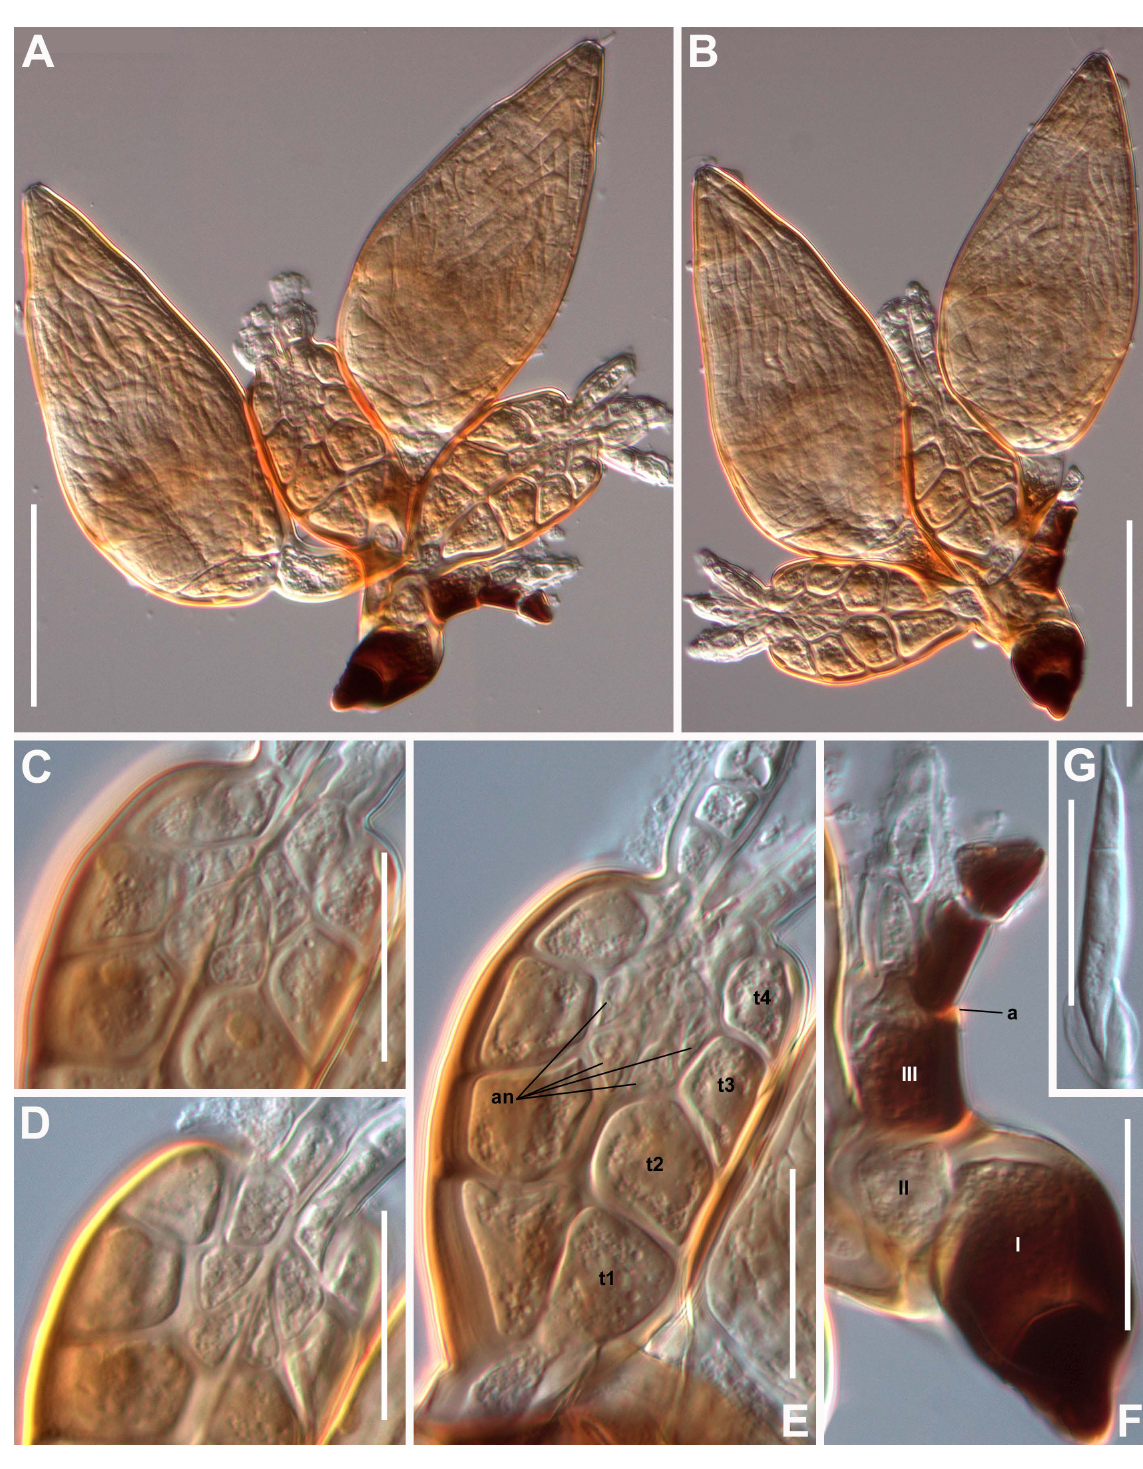
Fig. 91. Monoicomyces validus Santam. sp. nov. A – B . Mature thalli. C – E . Antheridium at three focusing levels. C – D . Respectively in near and far focus. E . Middle focus in detail with the four tiers of cells (t1–4), and four phialides (an). F . Lower receptacle (I, II, and III) and primary appendage in detail above the primary septum (a). G . Ascospore. Scale bars: A–B = 50 µm; C–G = 20 µm. Photographs from slide ZMUC C-F-122693